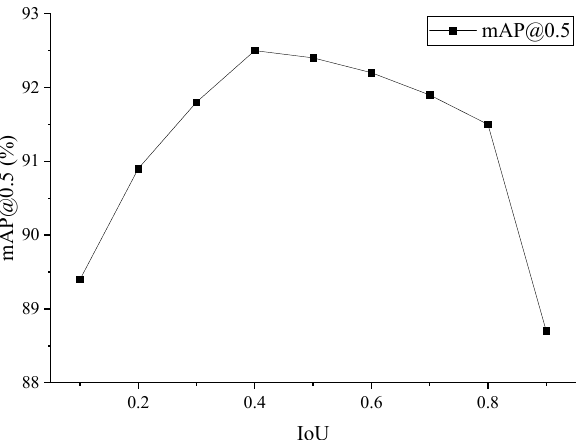
Figure 11. Experimental results of GNMS on the entire GF-6 image.